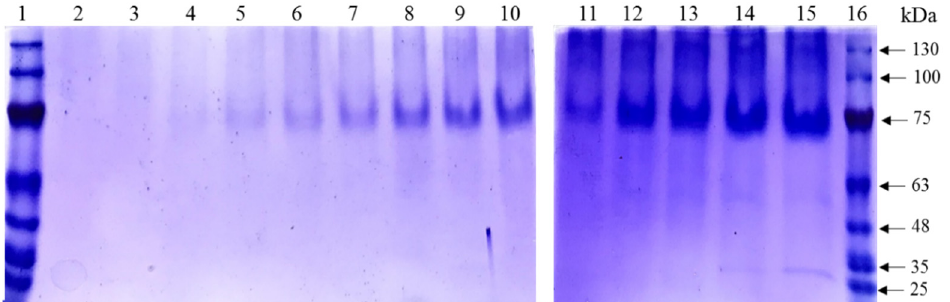
Figure 6. Polyacrylamide gel electrophoresis under denaturing conditions (SDS–PAGE) of the K. phaffii DEX49A– ∆ SP– ∆ N30 secreted proteins. In lanes 2–15, culture supernatants hours 0, 2, 4, 6, 8, 10, 12, 14, 16, 20, 24, 26, 28, and 30 of the fermentation. Lane 1 and 16: Molecular weight marker (BLUeye Prestained Protein Ladder, GeneDireX, Inc.